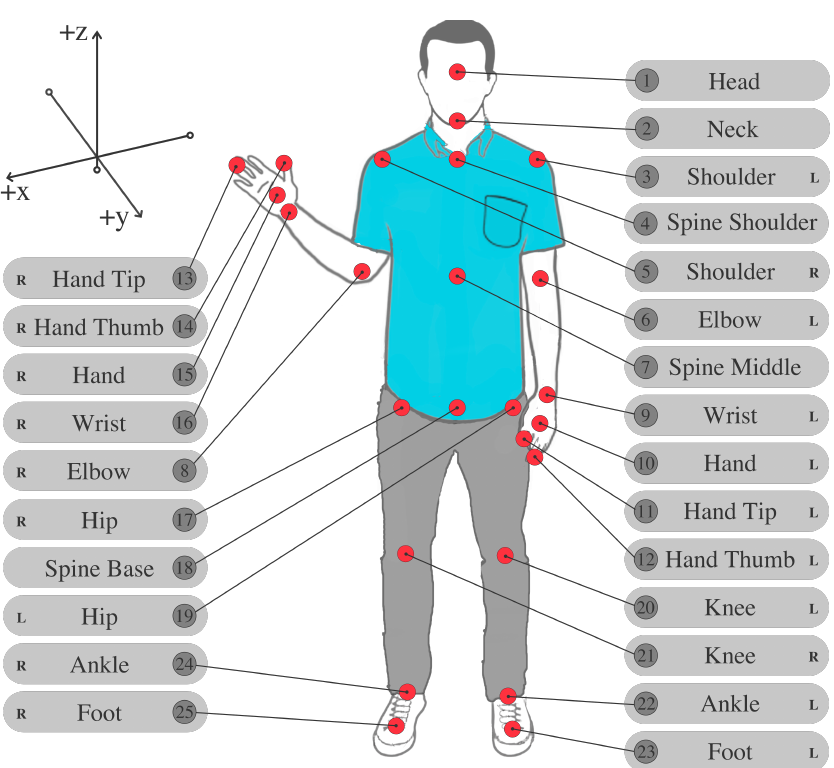
Figure 2. Skeleton-joint locations and names as captured by Microsoft Kinect sensor. Skeleton composed of 3D coordinates for each of its 25